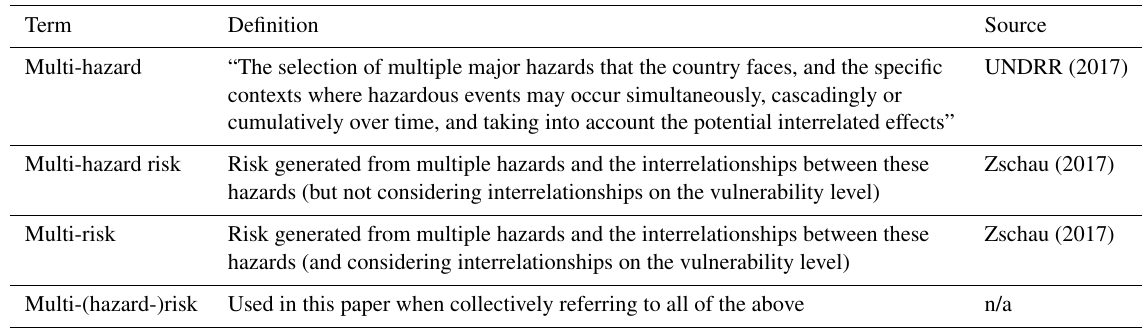
Table 1. Key definitions related to multi-(hazard-)risk.